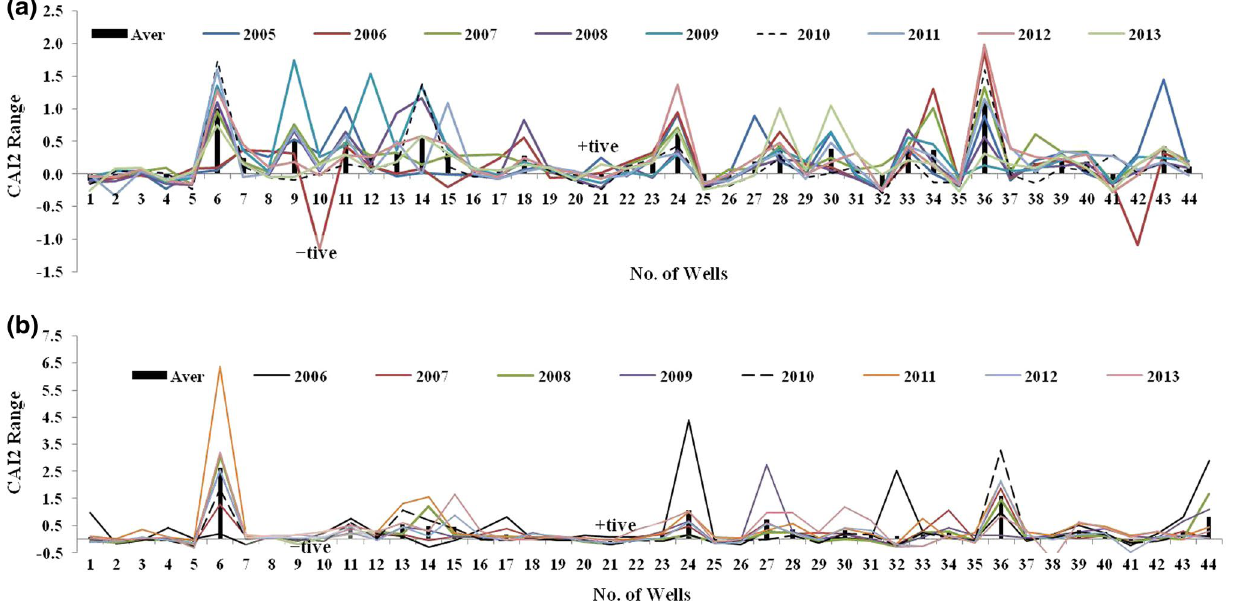
Fig. 10 a Nine-year (2005–2013) temporal representation of CAI2 value during pre-monsoon. b Nine-year (2006–2013) temporal representation of CAI2 value during